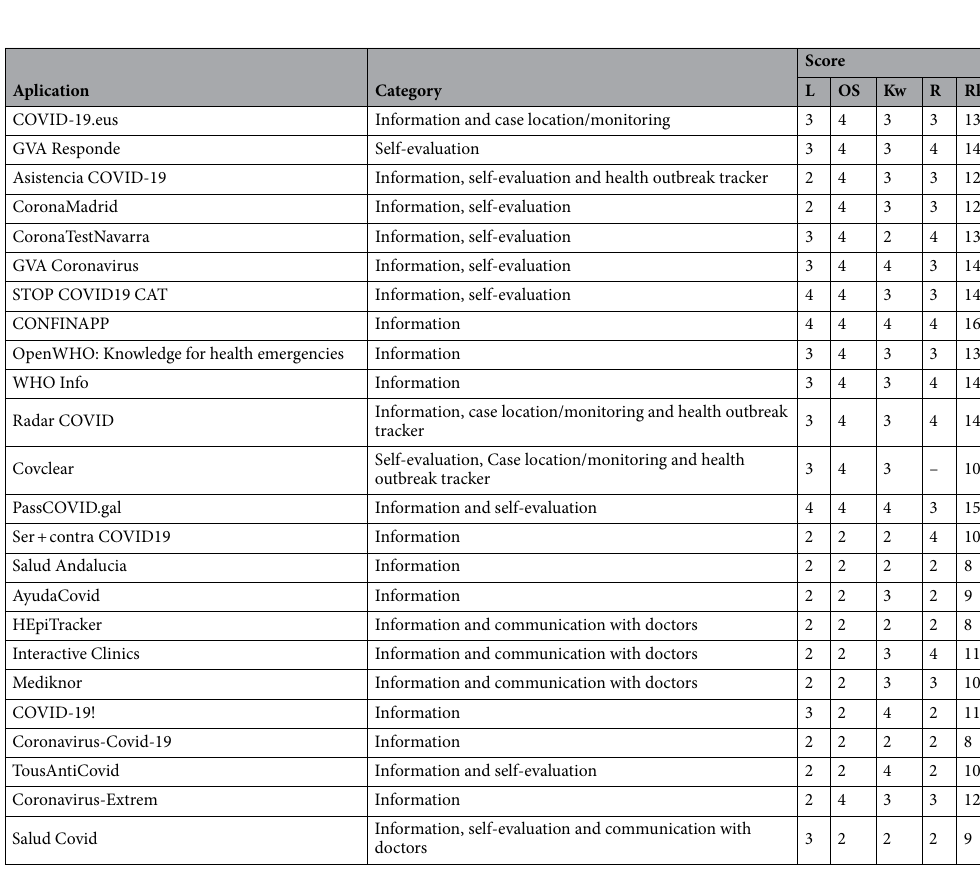
Figure 4. Percentage of downloads of the found apps.